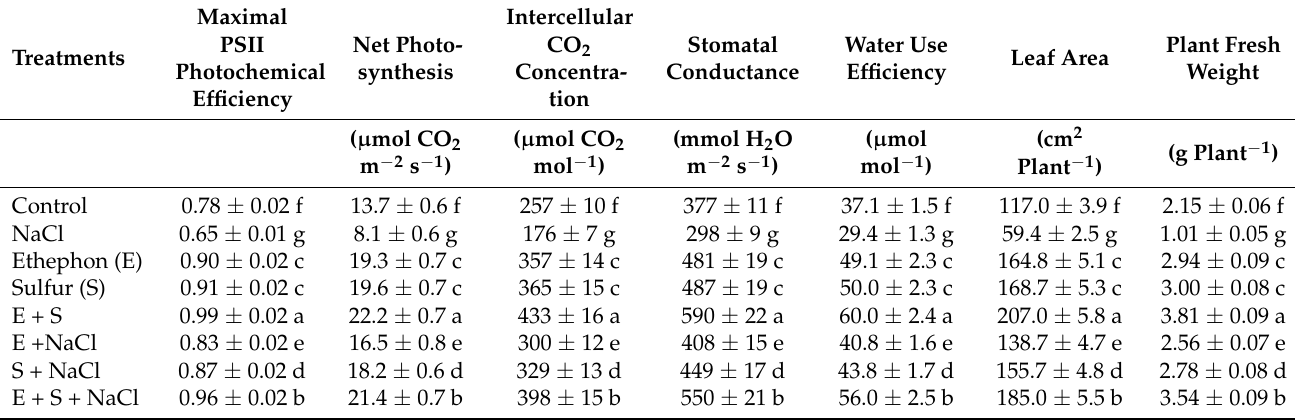
Table 5. Maximal PSII photochemical efficiency, net photosynthesis, intercellular CO 2 concentration, stomatal conductance, water use efficiency, leaf area and plant fresh weight of mustard leaves at 30 days after sowing. Plants were treated with 200 µ L L − 1 ethephon (E) and/or 200 mg S kg − 1 soil (S) in the presence or absence of 100 mM NaCl. Data are presented as means ± SE ( n = 4). Data followed by the same letter are not significantly different by LSD test at ( p < 0.05).